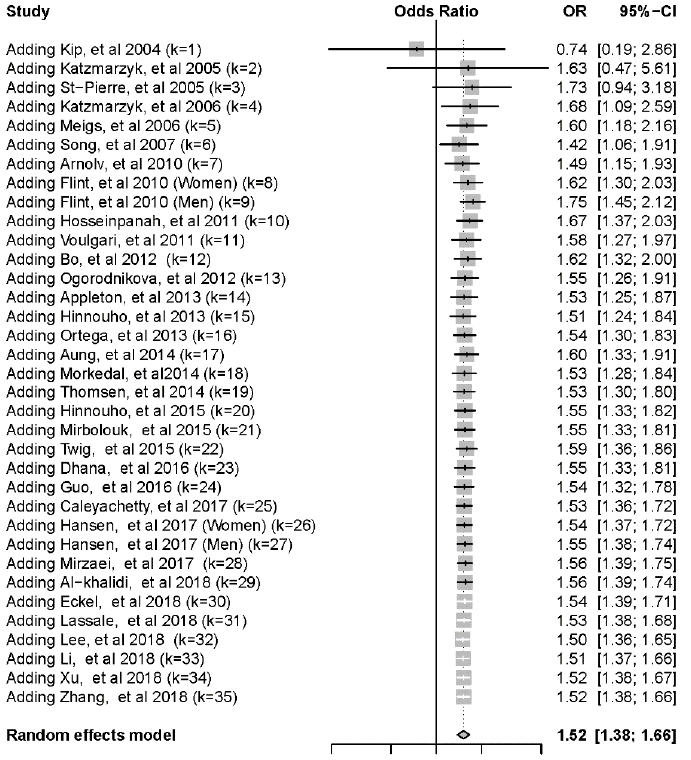
Figure 2. Cumulative forest plot of risk of cardiovascular disease from all included studies. CI, confidence interval; OR, odds ratio.